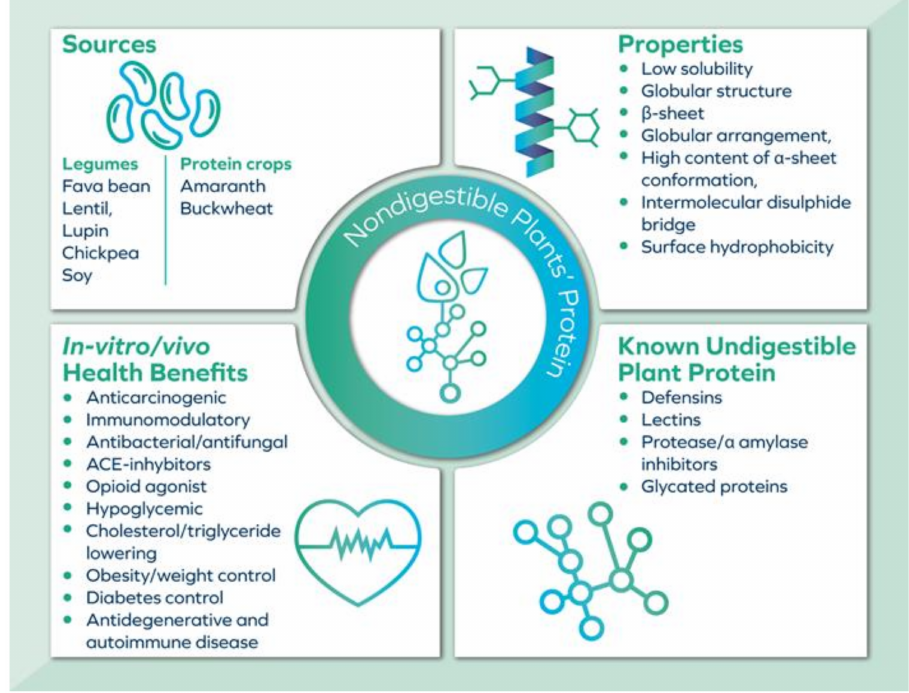
Figure 1. Principal physicochemical and biological properties of known classes of indigestible plant